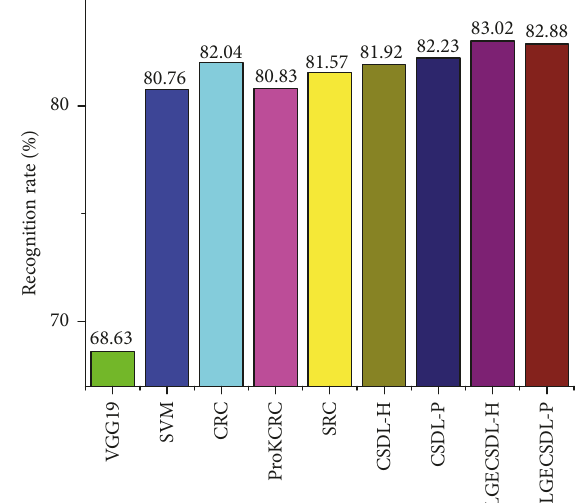
Figure 8: The best recognition rates of all the methods on Cal-